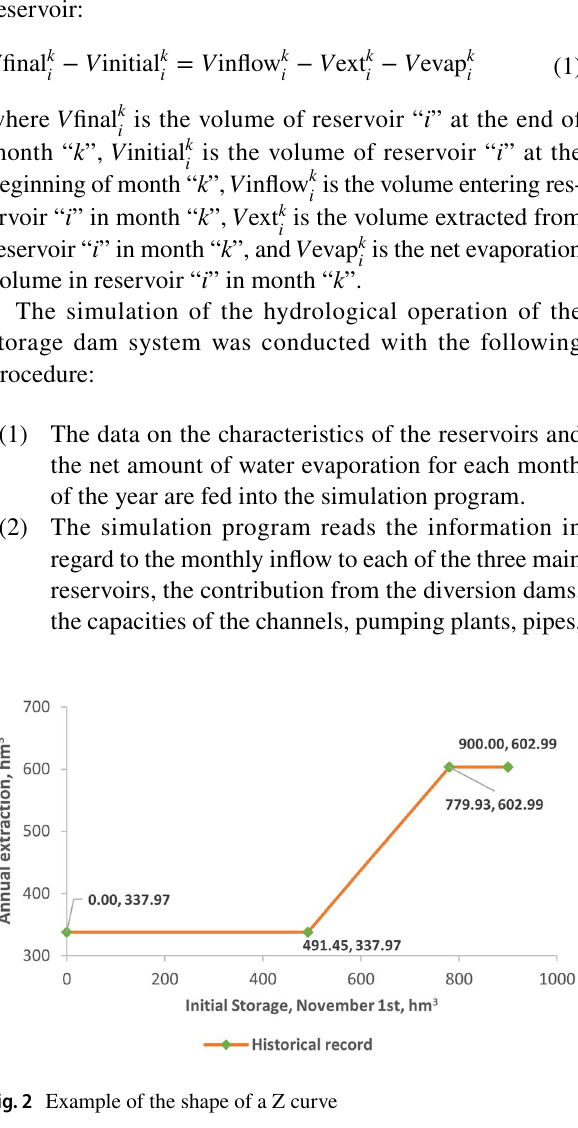
Fig. 2 Example of the shape of a Z